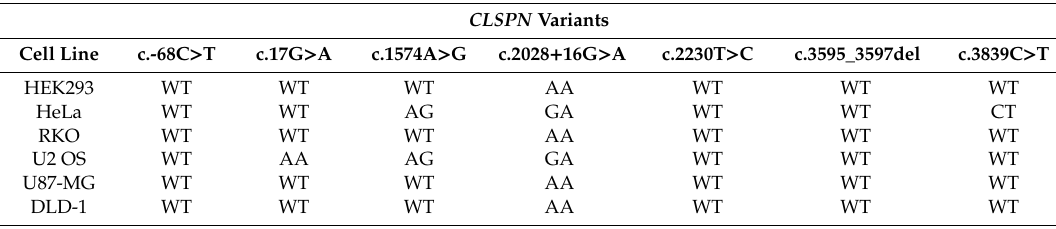
Table 3. CLSPN variants detected in cell line